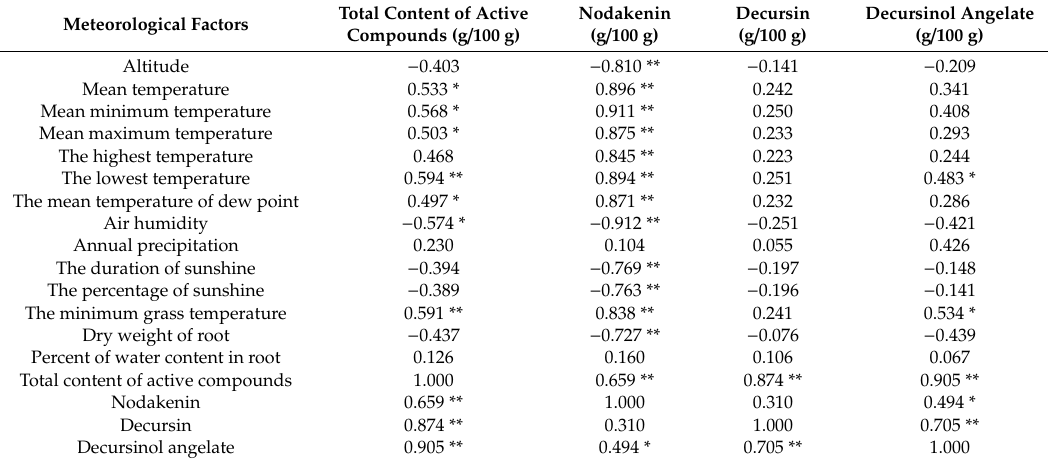
Table 7. Correlation coe ffi cients between active compounds and meteorological factors in Angelica gigas Nakai cultivation sites, Korea.